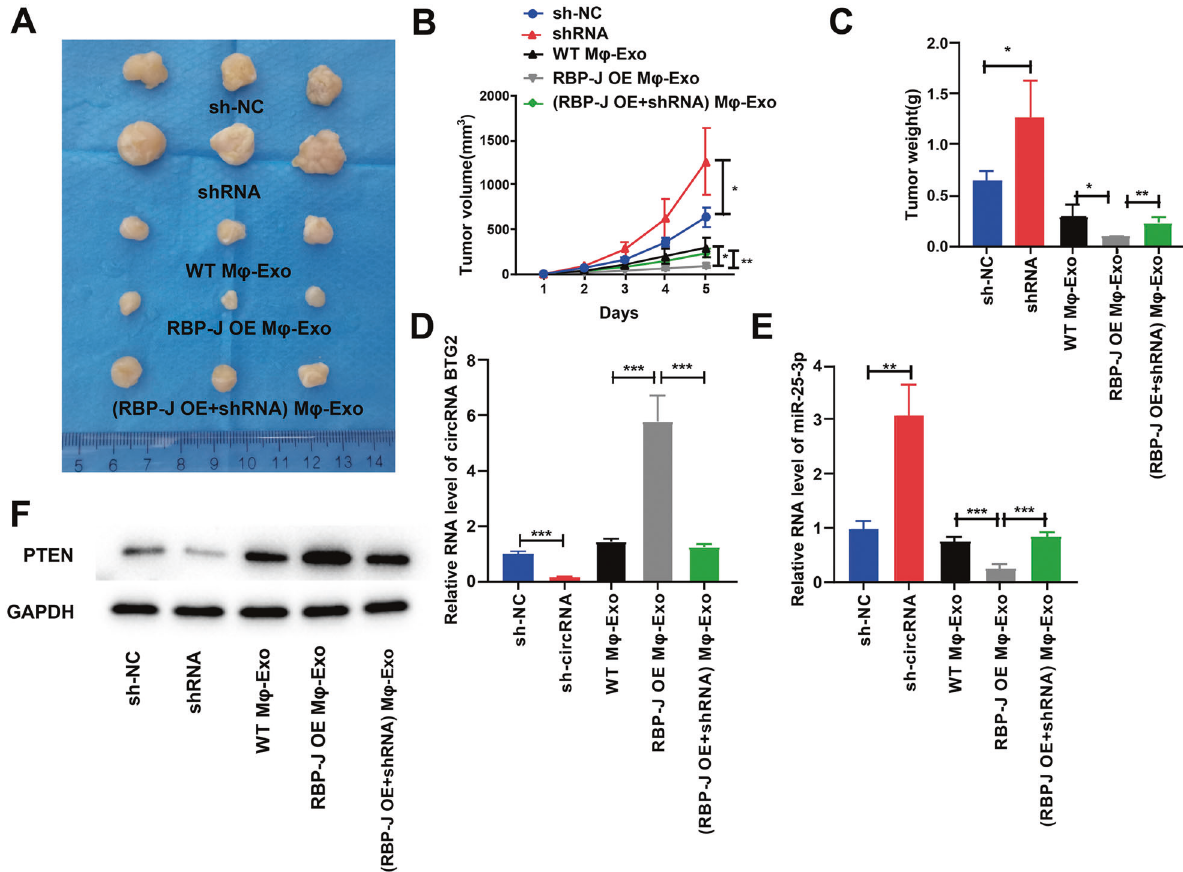
Fig. 7 RBP-J OE M φ -Exos inhibit tumor growth by circRNA BTG2/miR-25-3p/PTEN pathway in mouse xenograft tumor model. A Representative images of xenograft tumors (three mice per group) in nude mice. B Tumor volume is monitored every 7 days for 35 days. C The weights of xenograft tumors are summarized. D qRT-PCR veri fi cation of the expression of circRNA BTG2 in tumors ( n = 3). E qRT-PCR veri fi cation of the expression of miR-25-3p in tumors ( n = 3). F The protein expression of PTEN was detected by western blotting in tumors ( n = 3). * P < 0.05, ** P < 0.01, and *** P < 0.001 for statistical